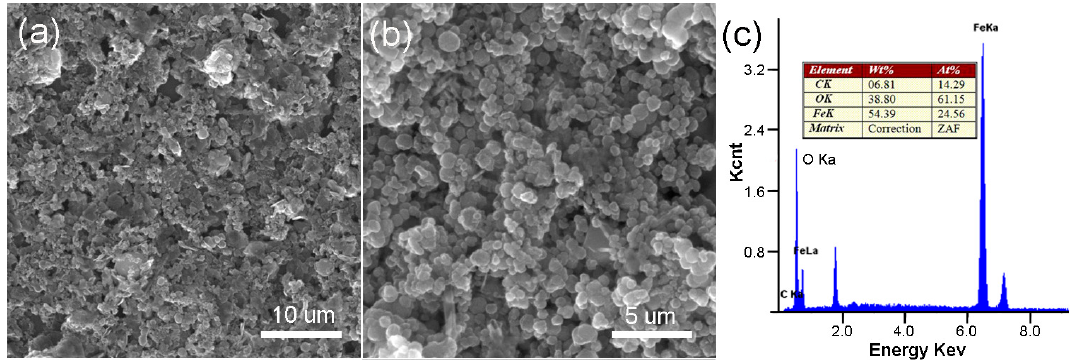
Figure 3. SEM (scanning electron microscopy) images of the r-GO/Fe 2 O 3 NPs with different magnifications ( a , b ) and corresponding EDX ( c ).